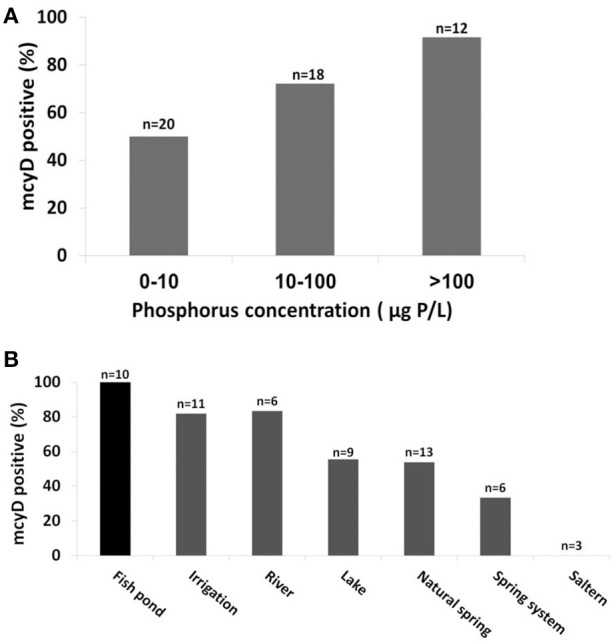
The probability of mcyD being detected in the water bodies increases with phosphorus concentrations and in aquaculture facilities. (A) A higher percent of mcyD gene presence was found in water with high P concentrations (a, p < 0.05). (B) Significant differences in the distribution of mcyD positive locations was observed among the different water body types (Kruskal-Wallis ANOVA analysis with p < 0.05). Note that all fish ponds contain toxinogenic Microcystis populations.